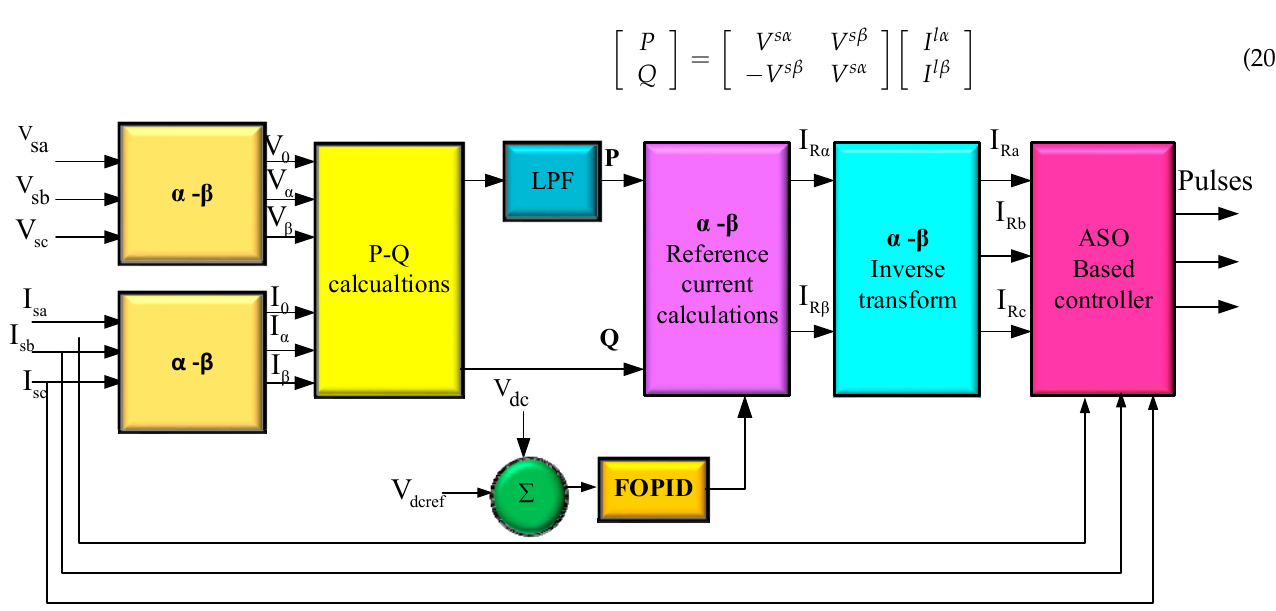
Figure 6. Block diagram of Shunt APF.